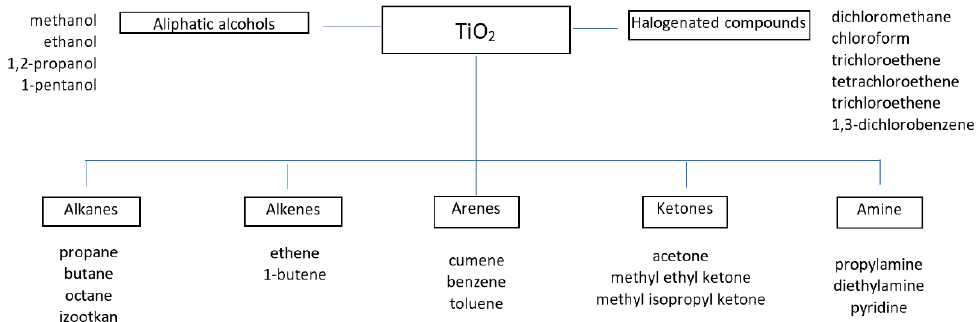
Figure 1. Organic pollutants removed from the air in the process of photocatalysis with TiO 2 .